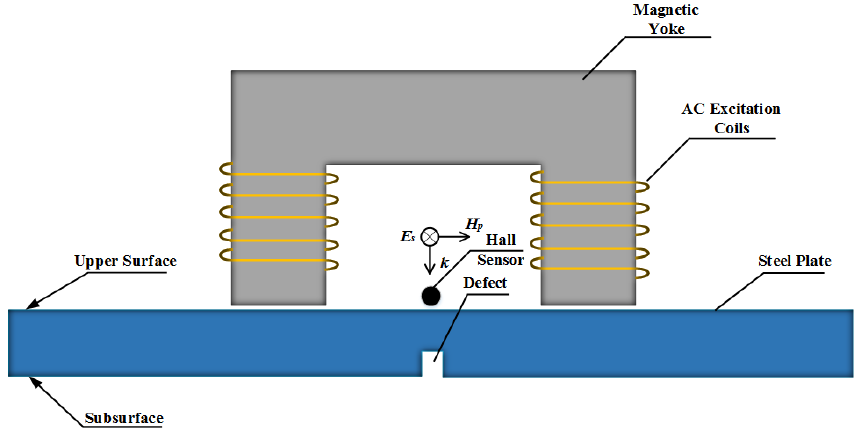
Figure 1. The proposed schematic of MFL measurement system.